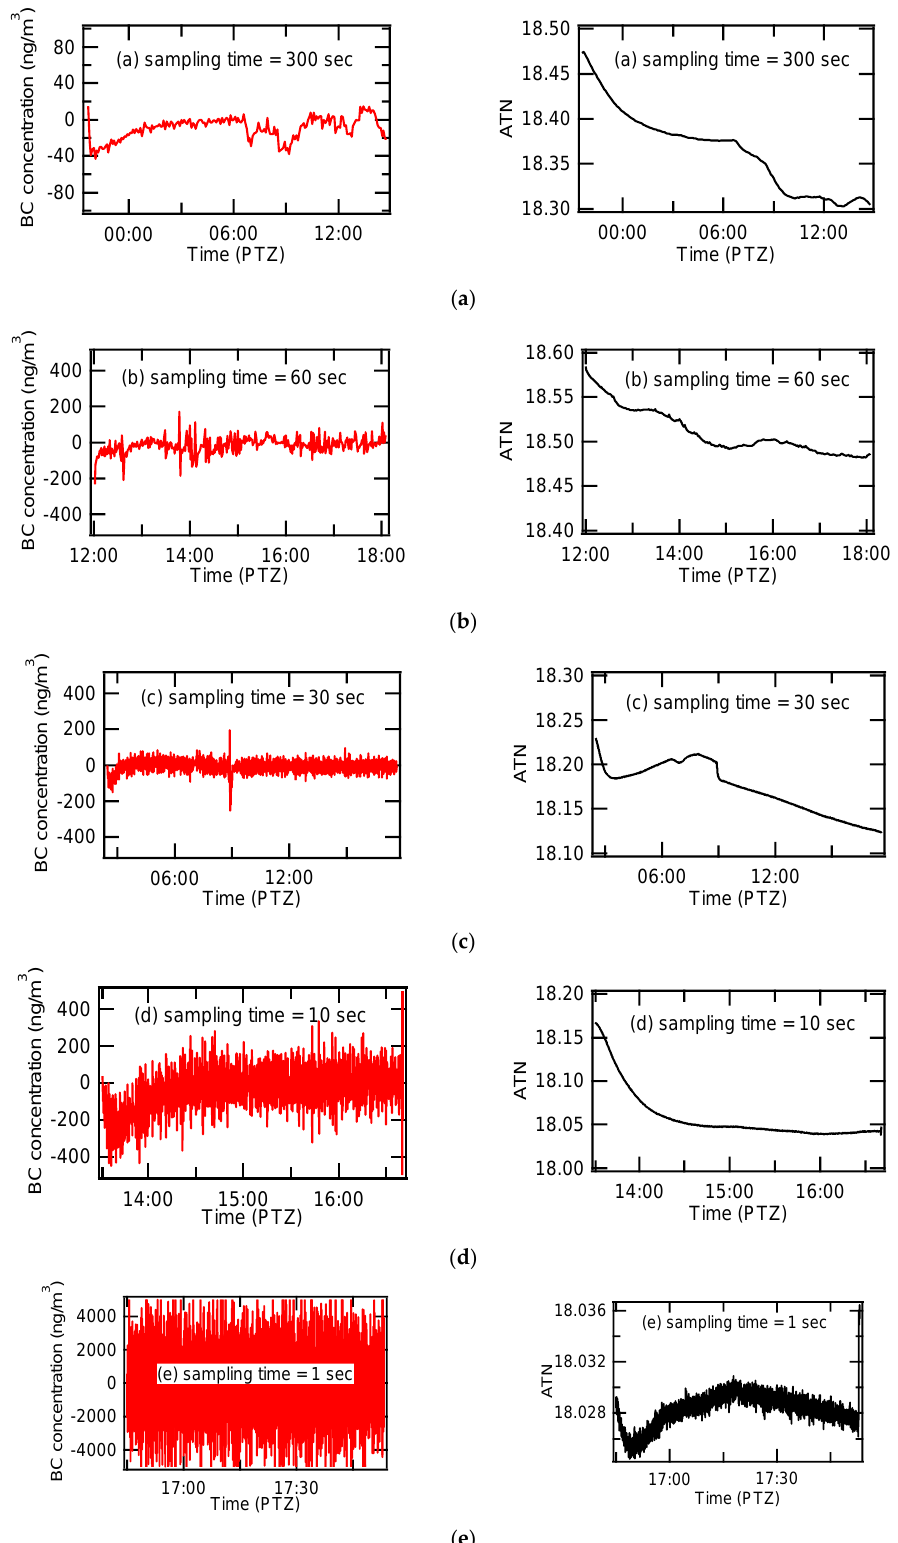
Figure 10. Black carbon (BC) concentrations and variation of attenuation (ATN) for filter-cleaned particle free air at the sampling time of ( a ) 300 s; ( b ) 60 s; ( c ) 30 s; ( d ) 10 s; ( e ) 1